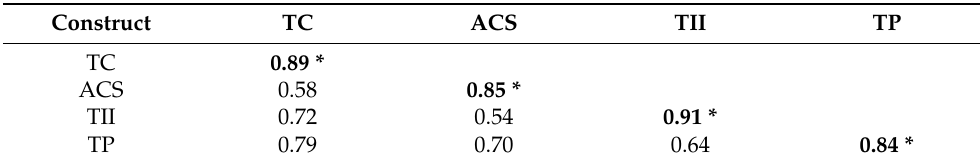
Table 8. Distinctiveness of